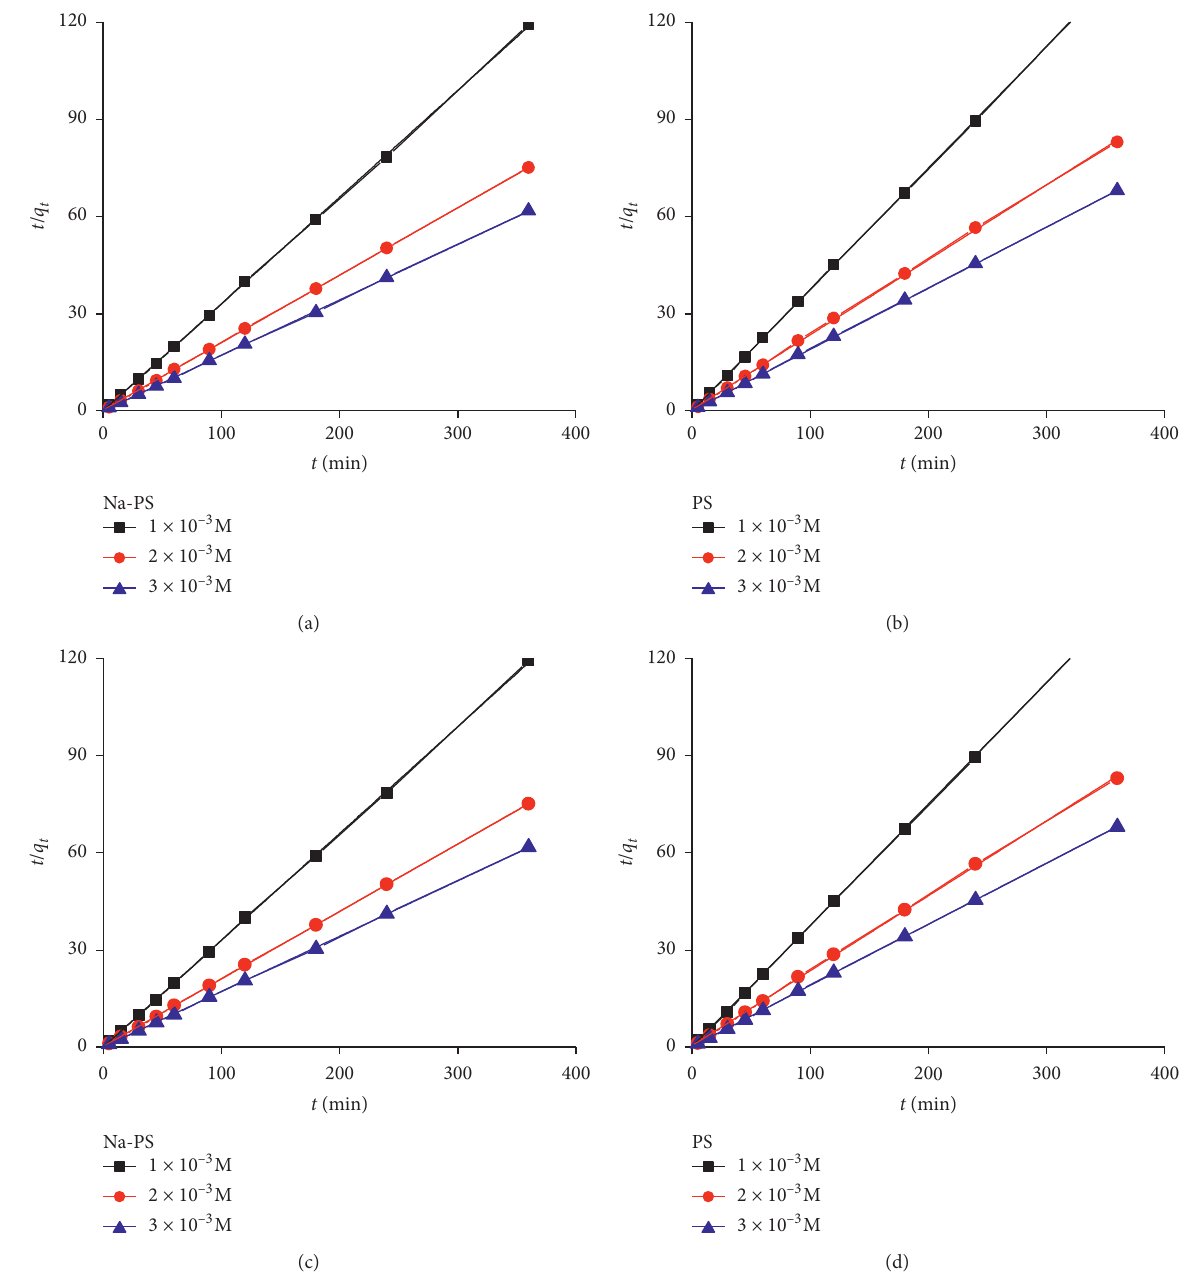
Figure 4: Pseudo-second-order plot for the adsorption of Cd(II) (a and b) and Cu(II) (c and d) on PS and Na-PS depending on the initial concentration. Note: PS means Pisha sandstone; Na-PS means Pisha sandstone modified with Na +